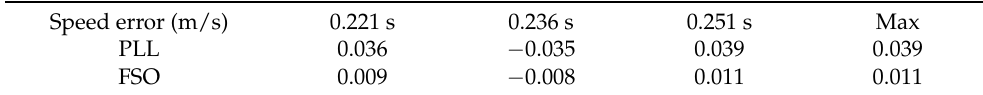
Table 2. Comparison of speed errors between FSO and PLL. Speed error